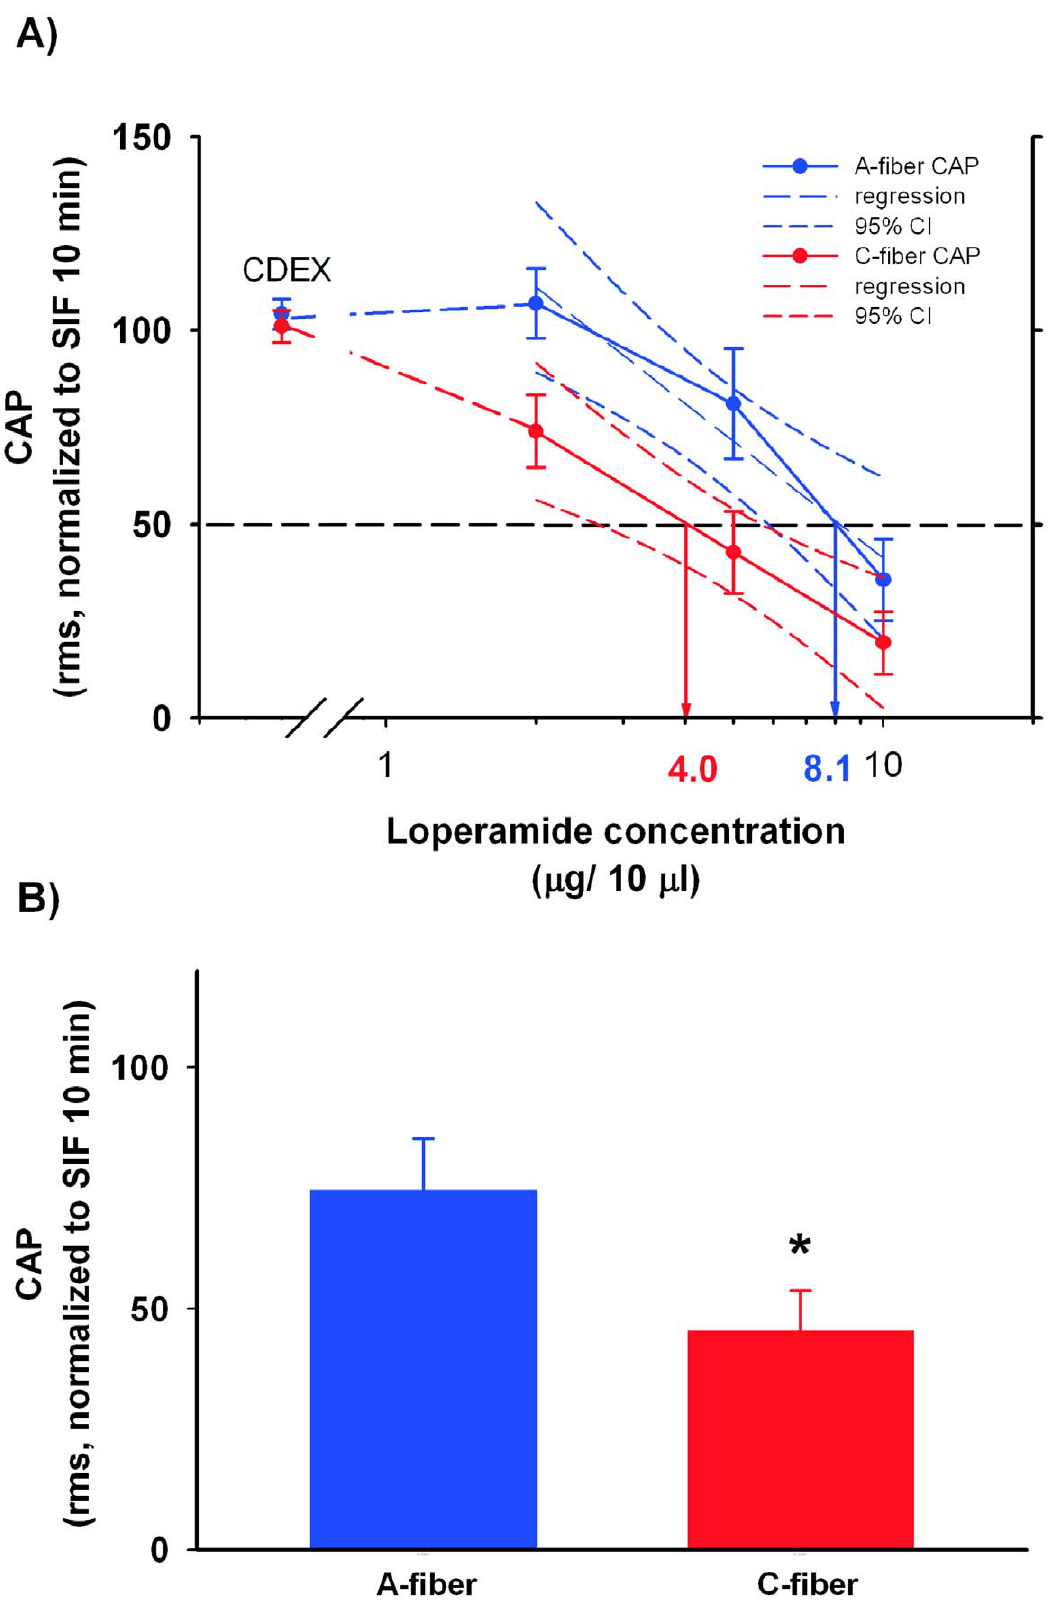
Figure 7. The conduction blockade by loperamide was dose-dependent. A) Dose response curves for the A- and C – CAPs were plotted, and regression analyses were performed for both to estimate the ED 50 . For the C-CAP (red symbols), the regression line and the dose response data